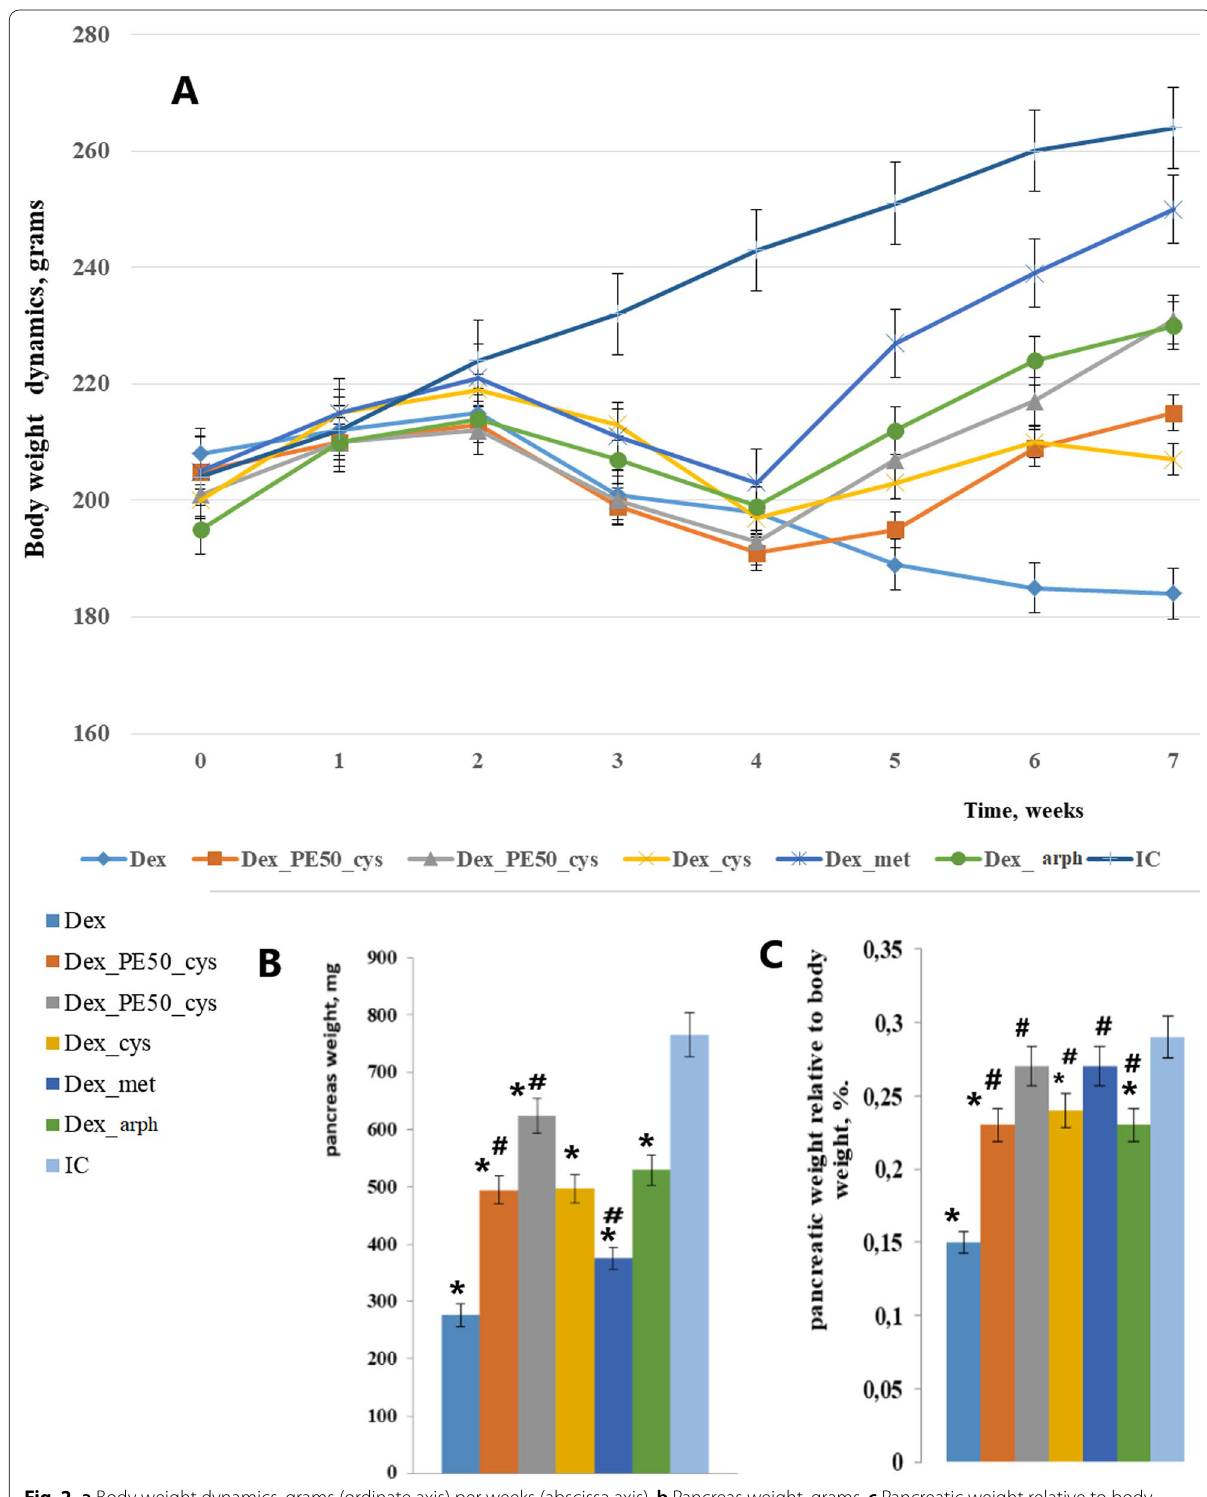
Fig. 2 a Body weight dynamics, grams (ordinate axis) per weeks (abscissa axis). b Pancreas weight, grams. c Pancreatic weight relative to body weight, %. Each value represents the mean significant difference relative to Dex group (p